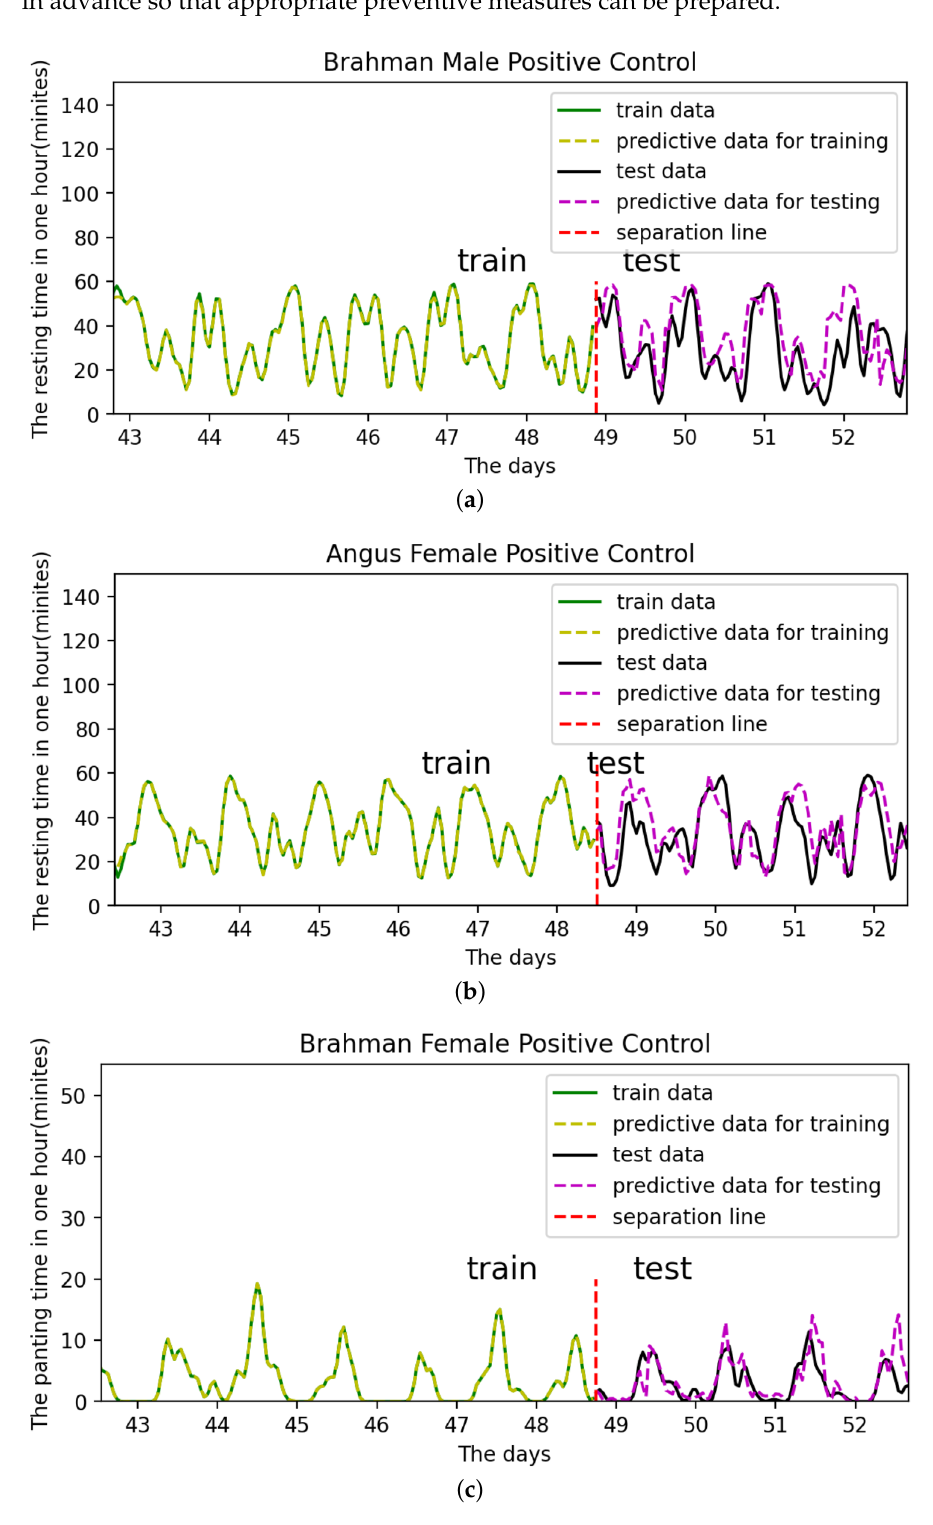
Figure 20. Applicability of the model. ( a ) Brahman Male cattle (Rest). ( b ) Angus Female cattle (Rest). ( c ) Brahman Female cattle